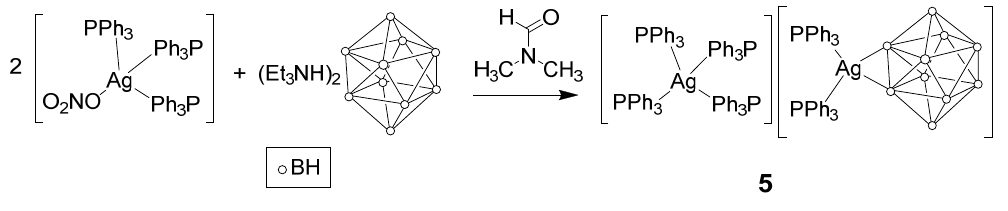
Figure 2. Molecular view of ( a ) 3 and ( b ) 4 in representation of atoms with thermal ellipsoids ( p = 50%). Solvent molecules are omitted.